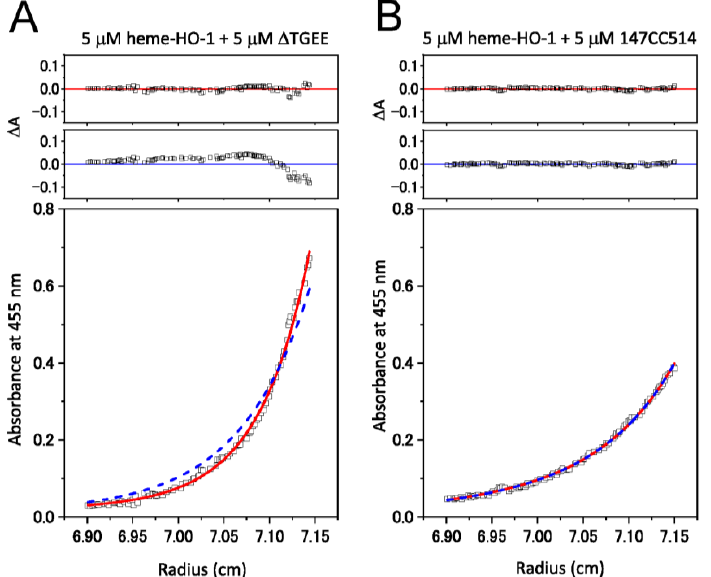
Figure 4. Sedimentation equilibrium analysis for heterodimer formation between heme – rHO-1 and ∆ TGEE ( A ) or 147CC514 ( B ). The concentration of each protein was 5 µ M. Absorbance data were collected at 15,000 rpm in a Beckman XL-A analytical ultracentrifuge. The data points fit to the complex (red lines) and non-complexed (blue dashed lines) models. The K d value of ∆ TGEE for heme–rHO-1 was estimated to be 0.178 ± 0.077 µ M. Residual fitting is depicted above both curve fits, with the complex model indicated in red, and the non-complexed model in blue.